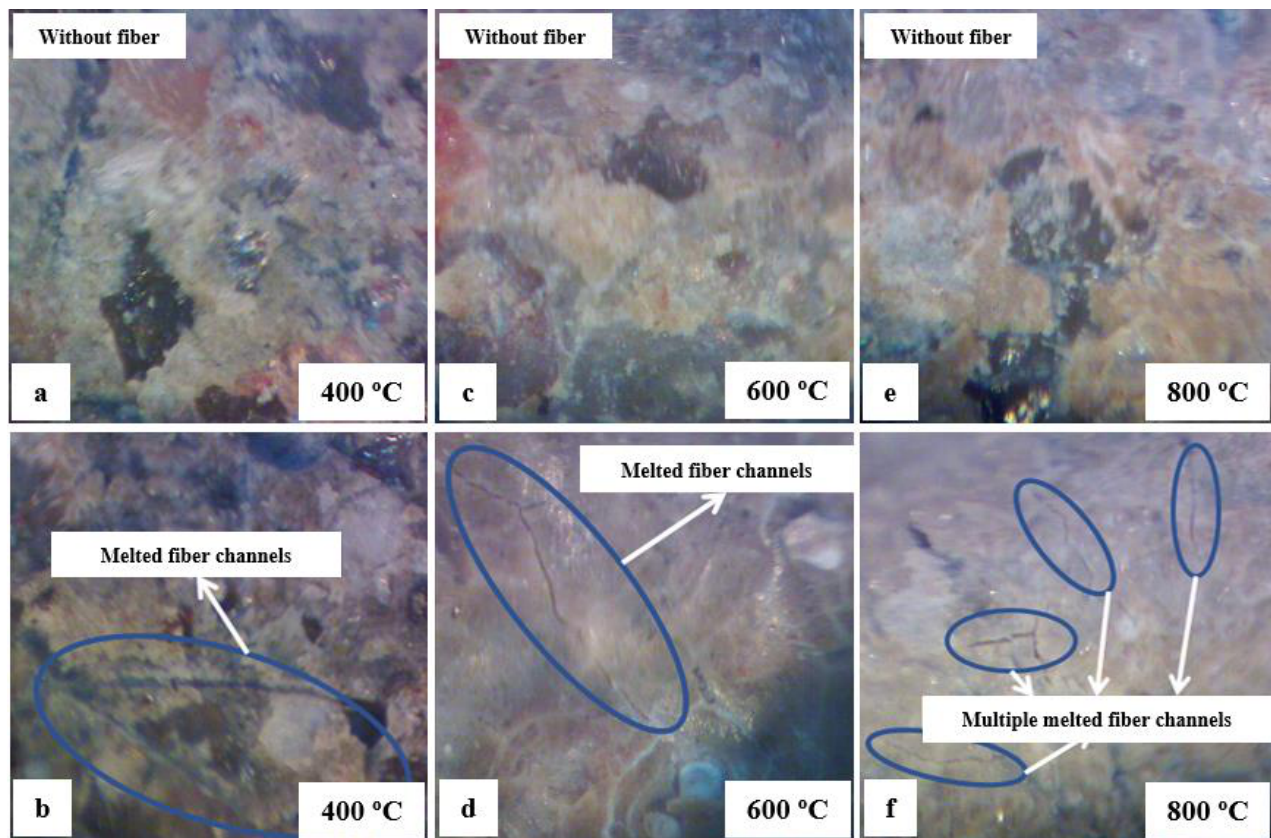
Figure 21. Microstructure of HSC: ( a ) 400 °C without fiber, ( b ) 400 °C with fiber, ( c ) 600 °C without fiber, ( d ) 600 °C with fiber, ( e ) 800 °C without fiber and ( f ) 800 °C with fiber.